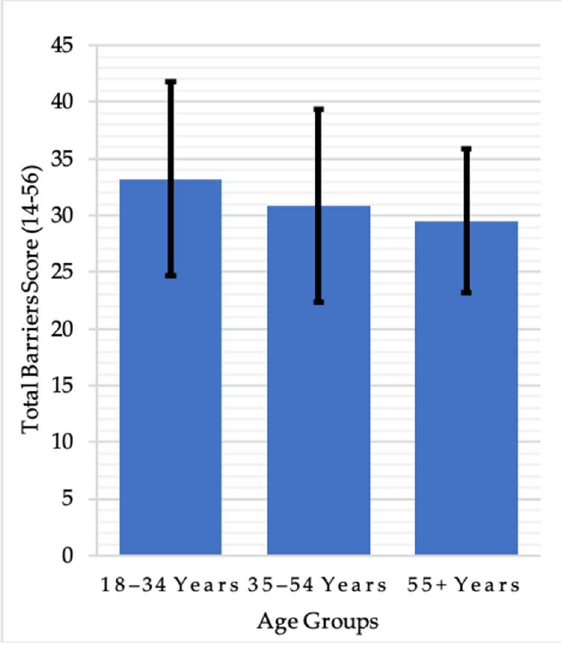
Figure 1. Differences in total barrier scores between age groups. Table 3. Physical activity context by gender and age